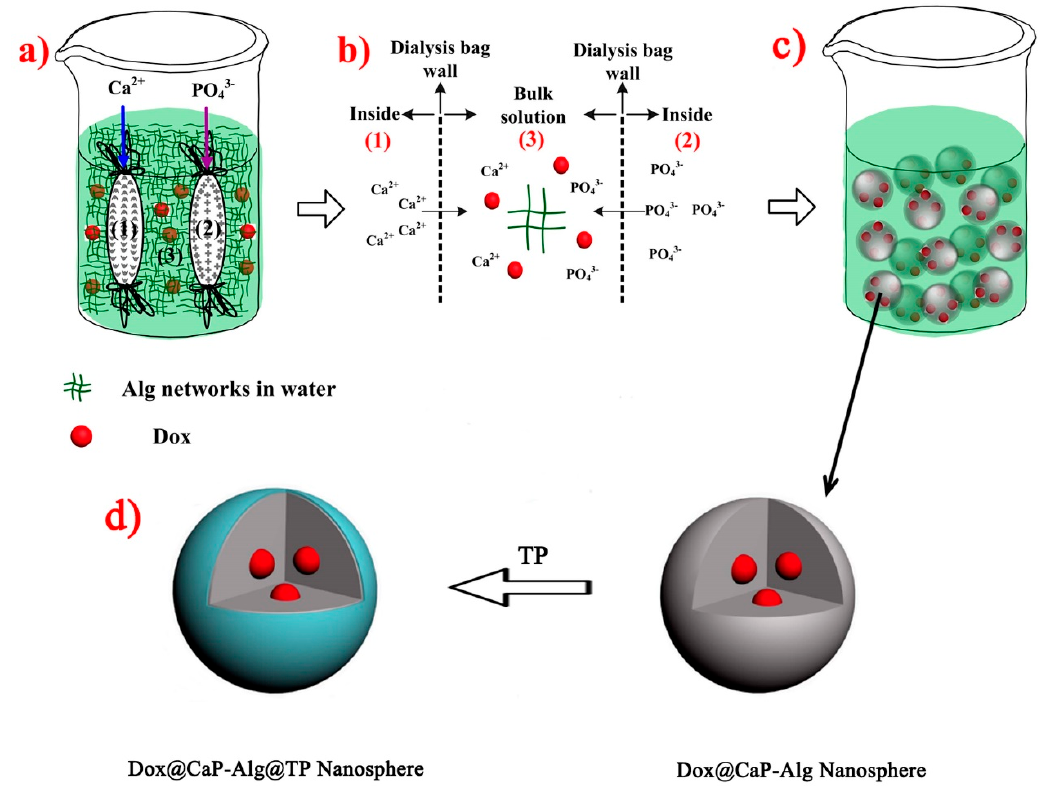
Figure 1. Schematic preparation process of Dox@CaP-Alg@TP (DCAT) nanospheres. ( a ) reaction system, ( b ) detail illustration of Ca 2+ and PO 43- gradually diffuse into the Alg networks, ( c ) illustration of formed CaP nanoparticles, ( d ) TP function process of CaP NPs to form DCAT NSs.